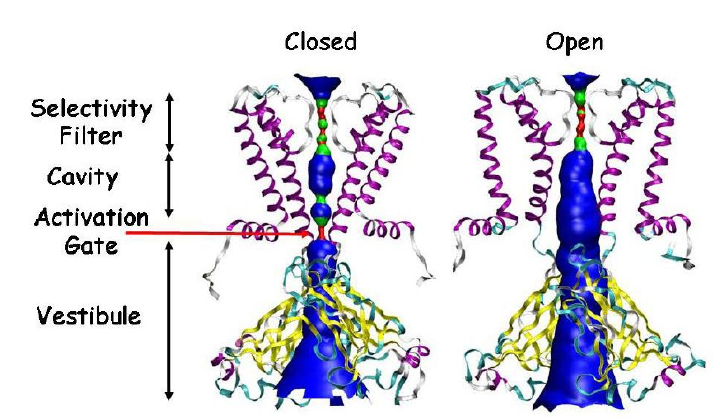
Fig. 3 Models of the closed and open conformers of KirBac1.1 represented as ribbons. Only two of the four subunits are shown for clarity. For each structure, the pore-lining surface is shown. Volume colored in red indicates that there is not enough space for a water molecule to pass, green where one or two water molecules could fit and blue represents the volume were many water molecules can fit. Molecular graphics images were prepared using VMD